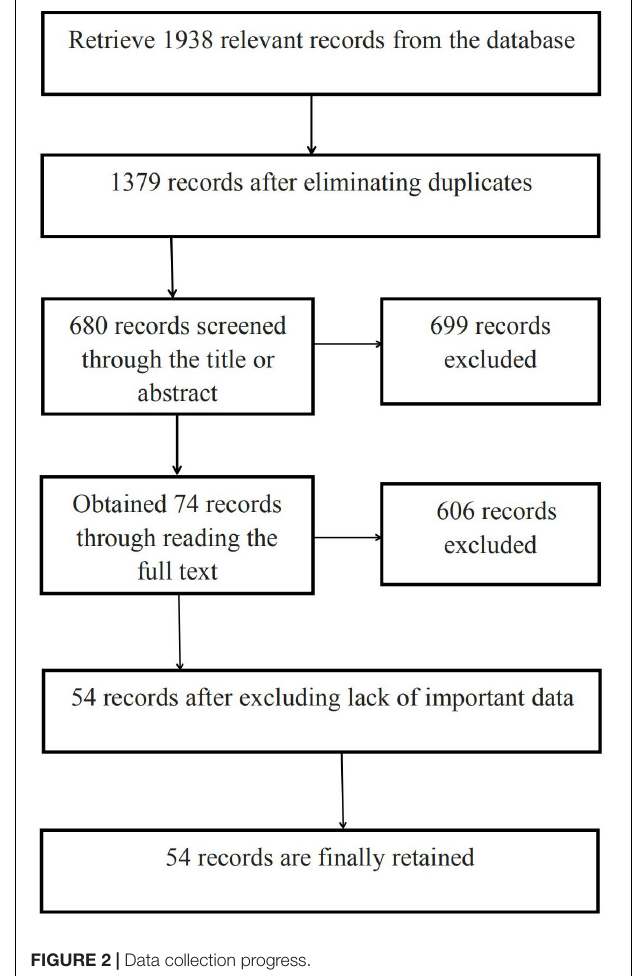
FIGURE 2 | Data collection